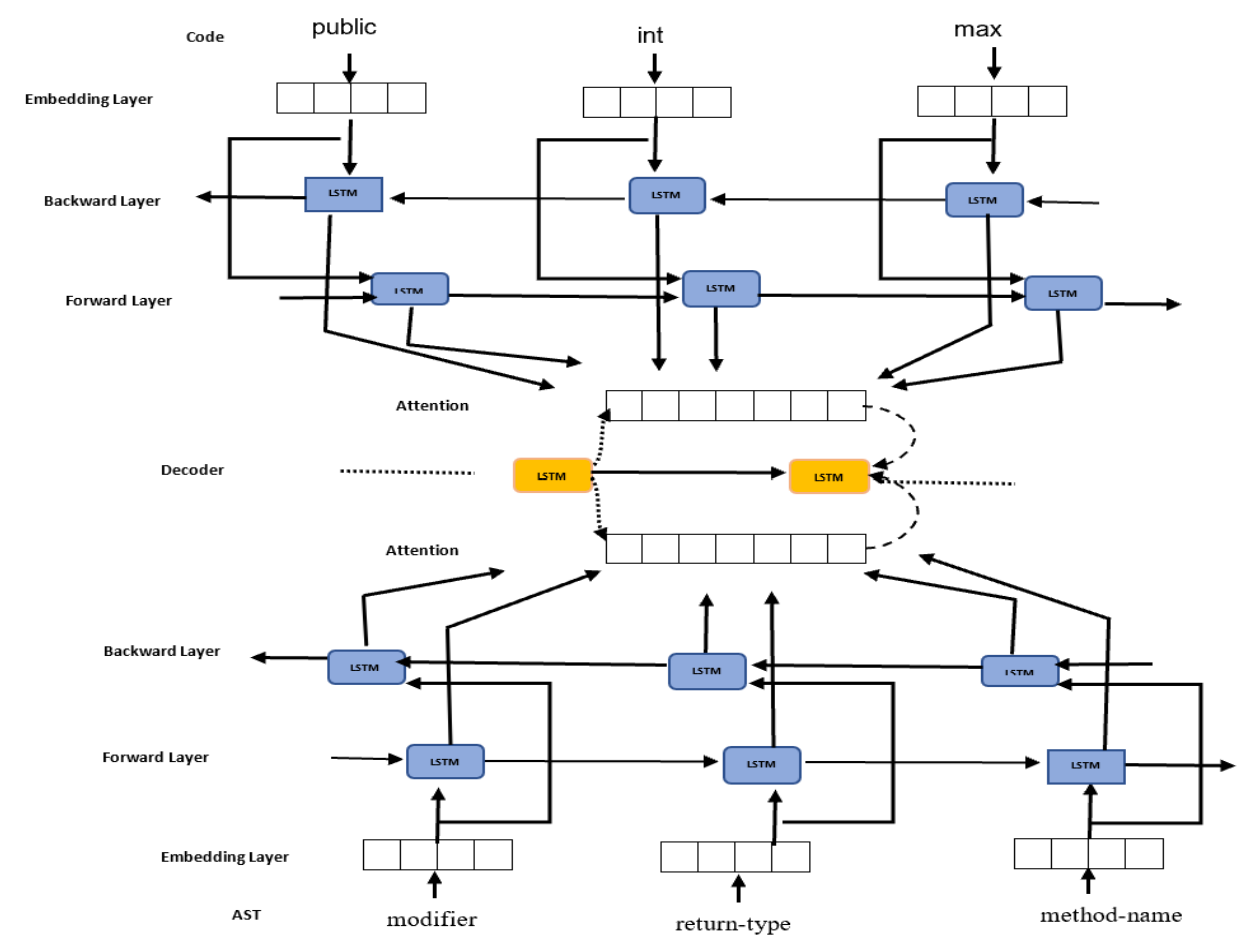
Figure 3. Model 1 Figure 3. Model 1 example .